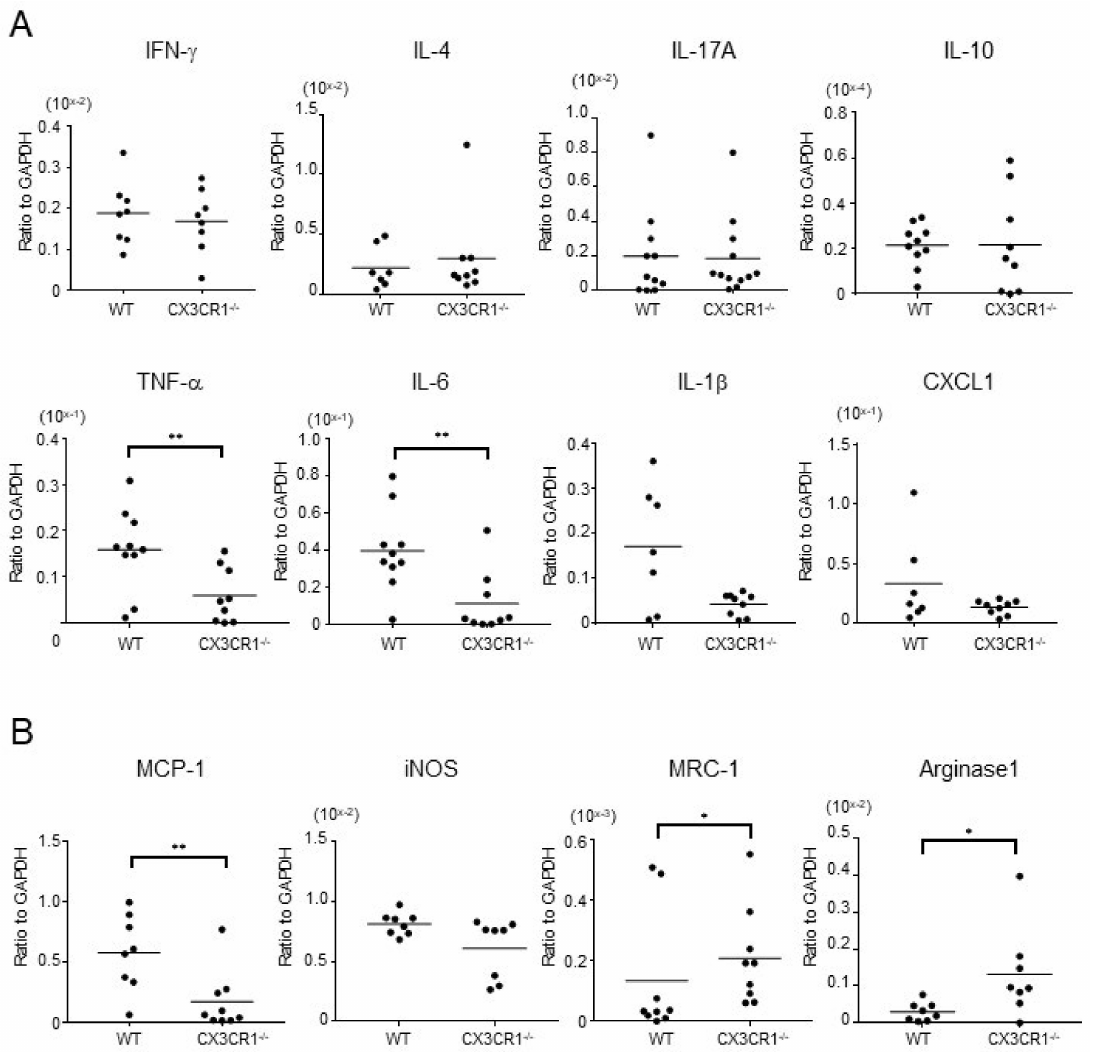
Figure 3. Expression of cytokines and chemokines produced by M1 macrophages is decreased and M2 macrophage marker expression is increased in the lesional skin of CX3CR1 − / − mice. ( A ) mRNA expression of interferon (IFN)- γ , interleukin (IL)-4, IL-17A, IL-10, tumor necrosis factor (TNF)- α , IL-6, IL-1 β , and CXCL1 in the ears from wild-type mice and CX3CR1 − / − mice at 48 h after DNFB challenge. Horizontal bars indicate mean values for each group of mice. n = 7–12. ** p < 0.01 by Mann–Whitney U-test. ( B ) mRNA expression of monocyte chemoattractant protein (MCP)-1, inducible nitric oxide synthase (iNOS), mannose receptor C type 1 (MRC-1), and arginase-1 in the ears from wild-type mice and CX3CR1 − / − mice at 48 h after DNFB challenge. Horizontal bars indicate mean values for each group of mice. n = 8–9. * p < 0.05, ** p < 0.01 by Mann–Whitney